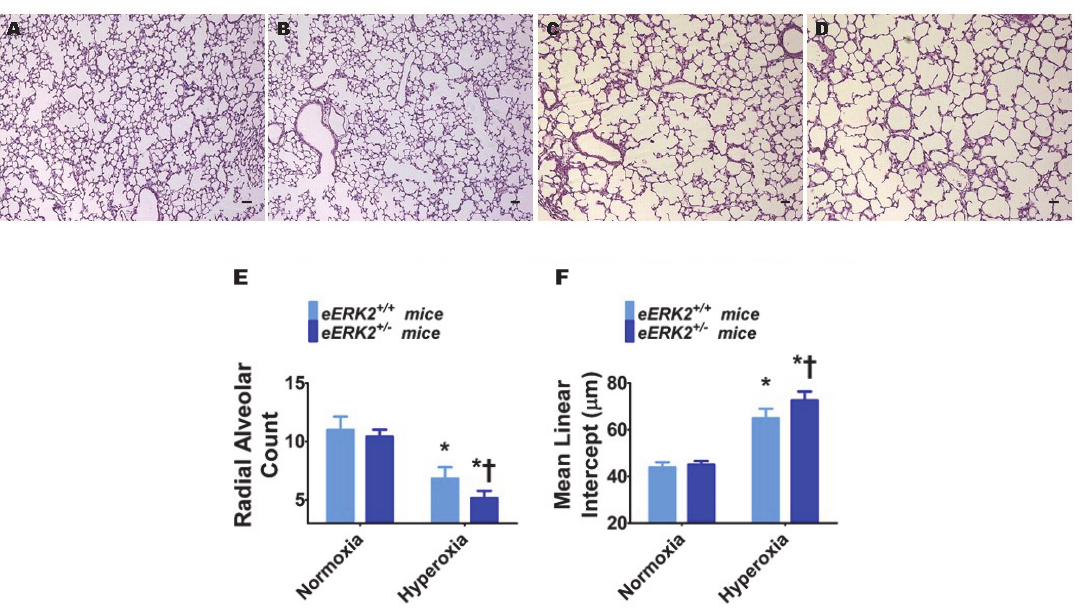
Figure 3. Lung alveolarization in endothelial ERK2 -sufficient ( eERK2 +/+ ) or -deficient ( eERK2 +/ − ) mice exposed to hyperoxia. One-day-old eERK2 +/+ or eERK2 +/ − mice were exposed to either 21% O 2 (normoxia) or 70% O 2 (hyperoxia) for two weeks, after which the lungs were harvested for lung morphometry. ( A – D ) Representative hematoxylin and eosin-stained lung sections from eERK2 +/+ ( A , C ) and eERK2 +/ − ( B , D ) mice exposed to normoxia ( A , B ) or hyperoxia ( C , D ). Scale bar = 100 µm. ( E , F ) Alveolarization was quantified by determining radial alveolar counts (RAC) ( E ) and mean linear intercepts (MLI) ( F ). Values are presented as the mean ± SD ( n = 4–5/genotype/exposure). Significant differences between eERK2 +/+ and eERK2 +/ − mice in hyperoxic conditions are indicated by †, p < 0.05. Significant differences between normoxia and hyperoxia groups are indicated by *, p < 0.05 (ANOVA).